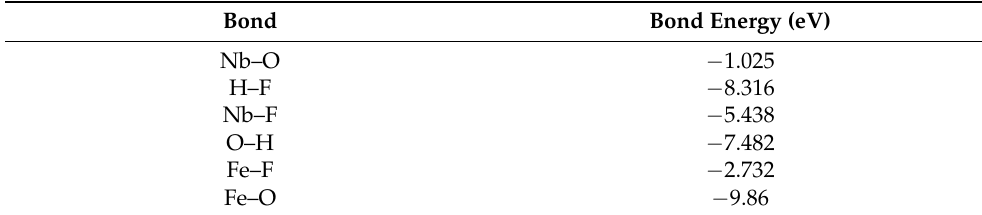
Table 7. Average bond energy calculated under different